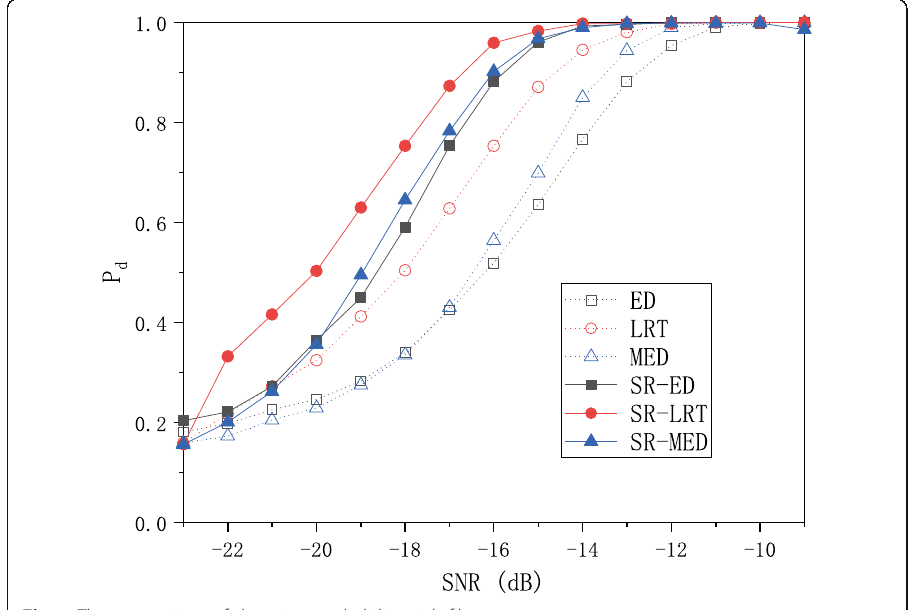
Fig. 7 The comparison of detection probability with